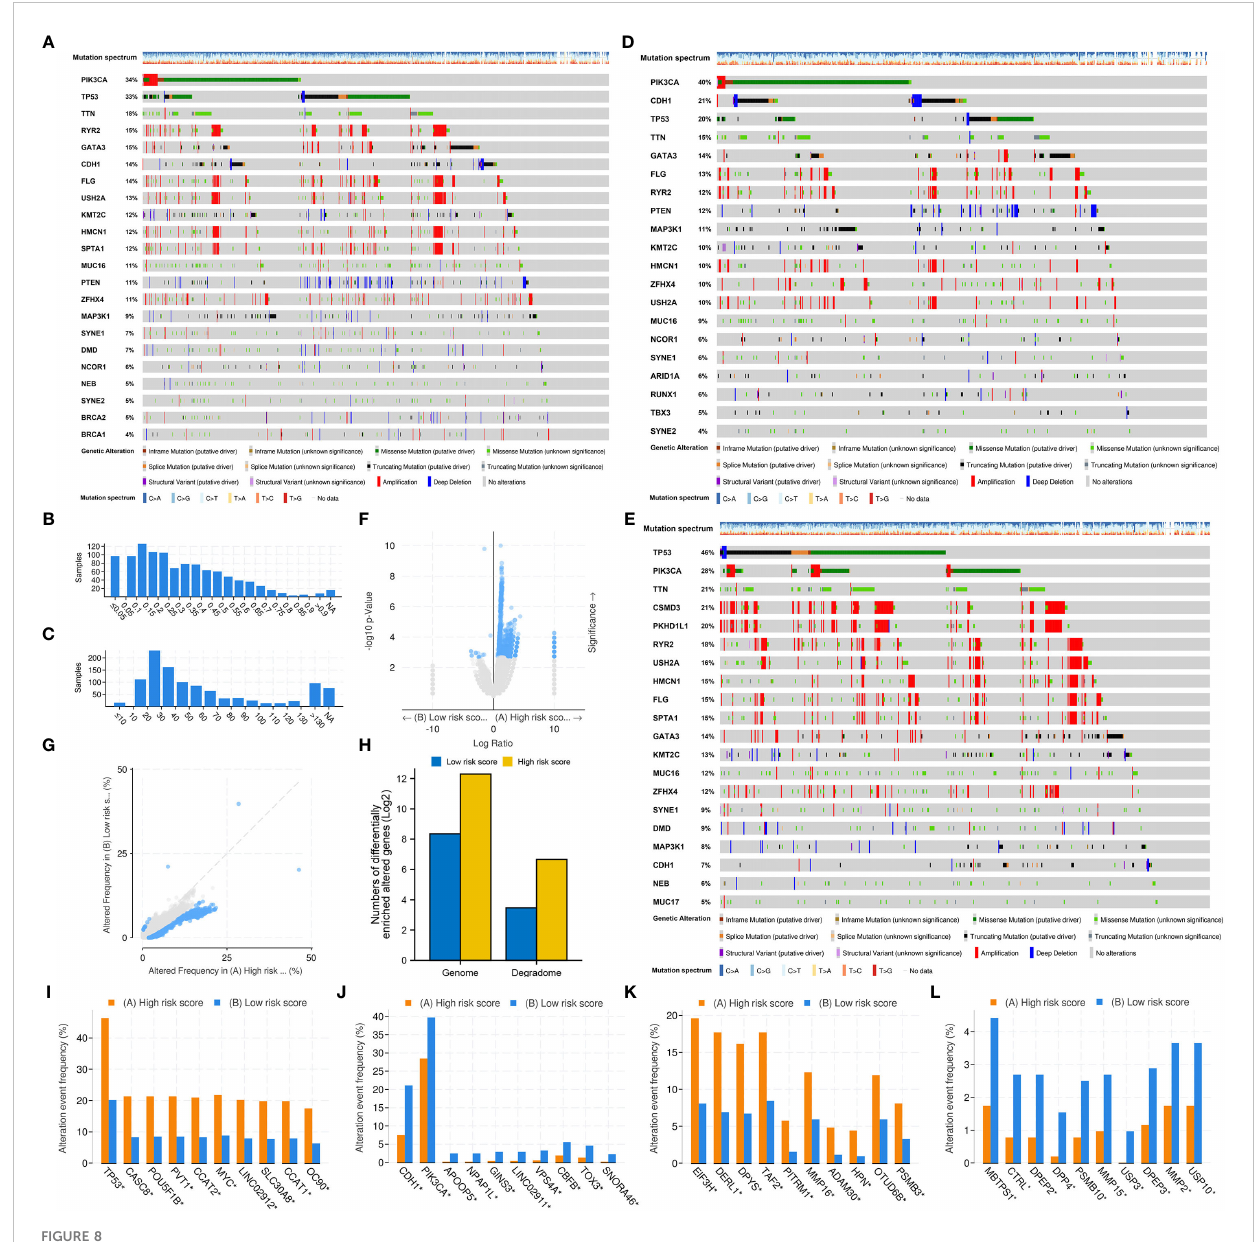
FIGURE 8 Mutation differences between the low- and high-risk groups. (A) Mutation landscape of the whole TCGA-BRCA cohort. (B) Fraction of genome altered. (C) Gene mutation count. (D) Mutation landscape of the low-risk group. (E) Mutation landscape of the high-risk group. (F, G) Signi fi cantly altered genes between the low- and high-risk groups. (H) Genes with signi fi cantly different mutation frequencies in the entire genome and degradome in the two risk groups. (I, J) The top 10 genes with signi fi cantly different mutation frequencies in the high- and low-risk groups. (K, L) The top 10 DRGs with signi fi cantly different mutation frequencies in the high- and low-risk